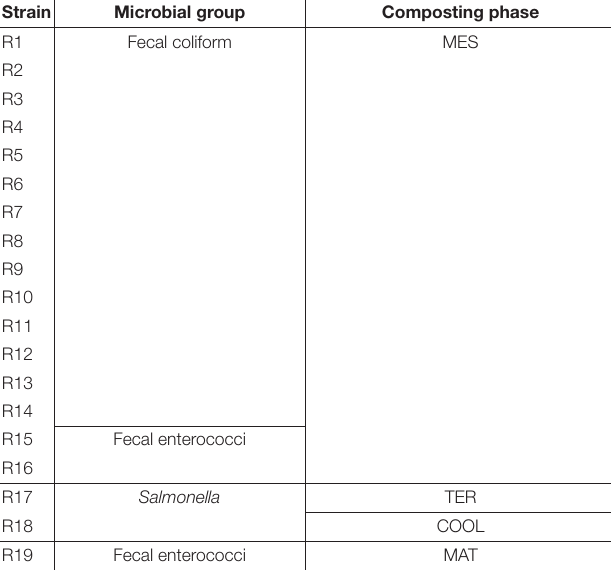
TABLE 2 | Group of strains isolated of each positive result of the fecal contamination during the composting process in SS1 with its codes. Strain Microbial group